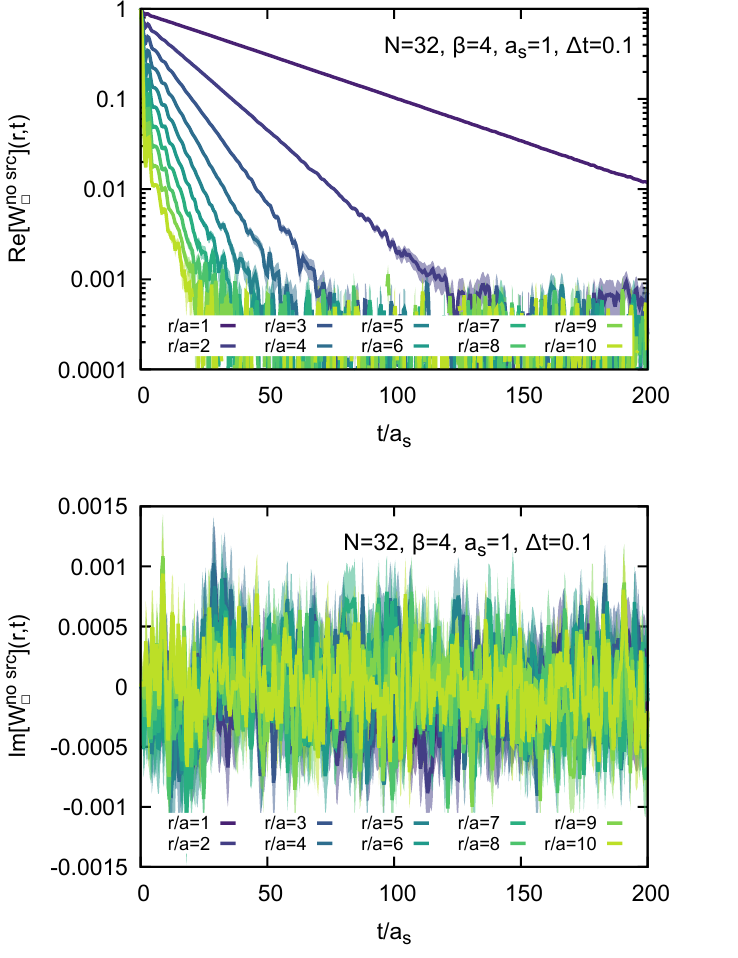
Figure 1 . Real- (top) and imaginary (bottom) part of the trace of the real-time Wilson loop evaluated at different spatial on-axis separation distances between r = 1 . . . 10 a s on N x = 32 lattices with β = 4 in the absence of a back-reaction between static sources and the surrounding medium. The real part of the Wilson loop is positive and exhibits clear exponential damping, while the imaginary part is compatible with